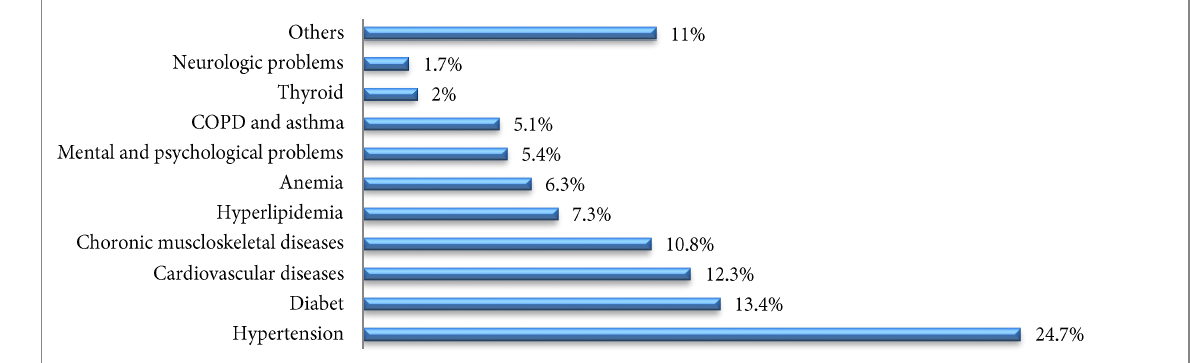
Figure 1. Prevalence of chronic disease in patients referred to Iranian clinics in Iraq from April to May 2013